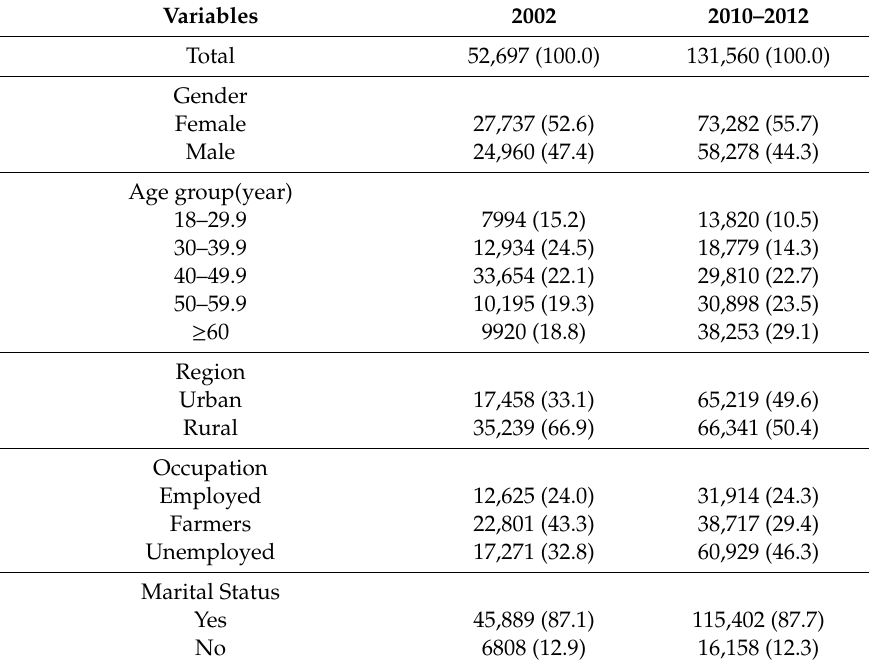
Table 1. Characteristics of participants by survey year [ n